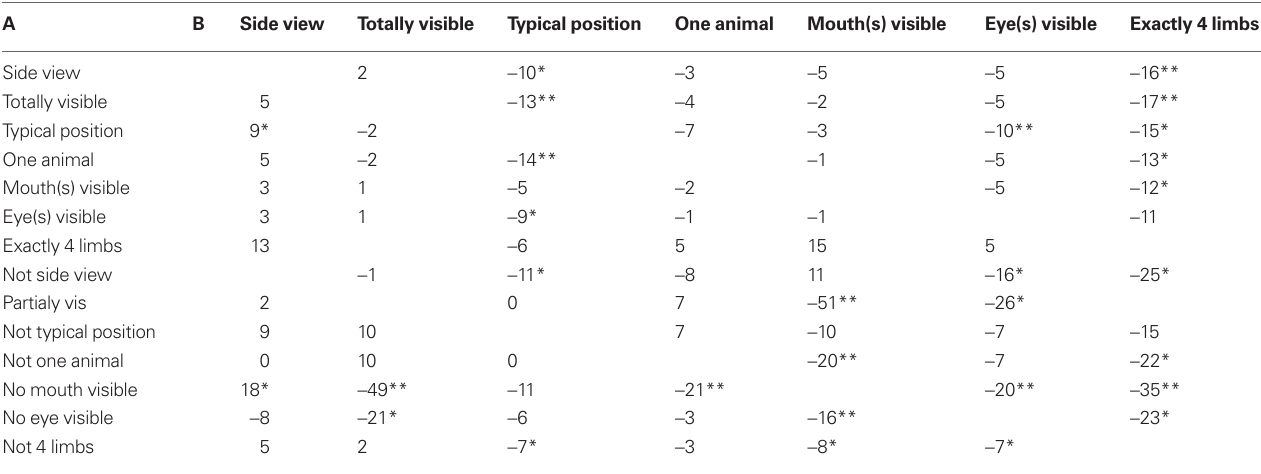
Table 2 | gain for conjunction of features A and B (in ms). Median reaction times were computed separately for the set of images containing feature A without feature B and the set of image containing both A + B. Then the median reaction time computed for the images containing A + B was subtracted from the median reaction time computed for the set of images containing A (without B). All negative values indicate that response was speedup when feature B was added to feature A. The values for A in conjunction with “non B” are opposite to the values of A in conjunction with B and have not been represented.